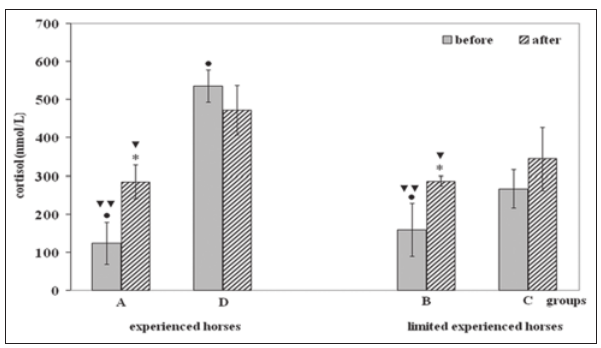
Figure-2: Circulating adrenocorticotropic hormone concentrations (mean±standard deviation) of